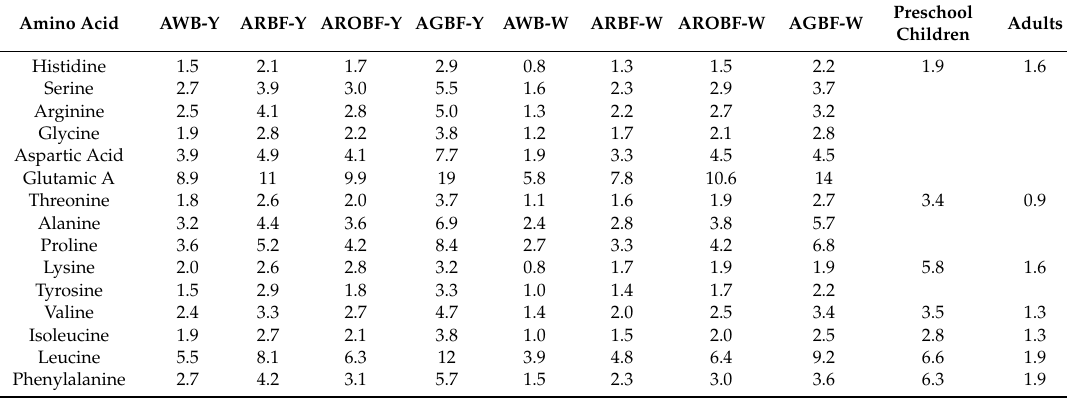
Table 4. Amino acid profile of amahewu samples (g / 100 g protein).